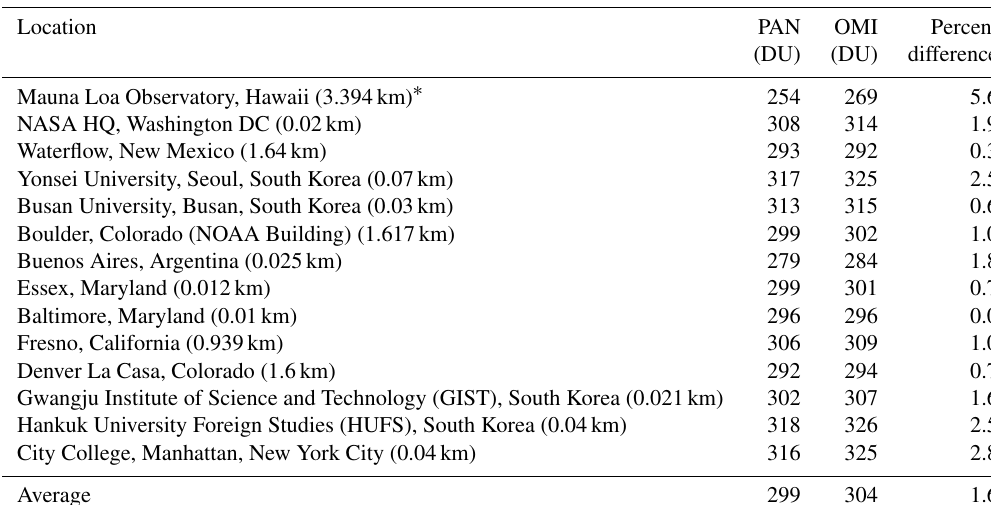
Table A1. Average values of TCO 3 for PANDORA and